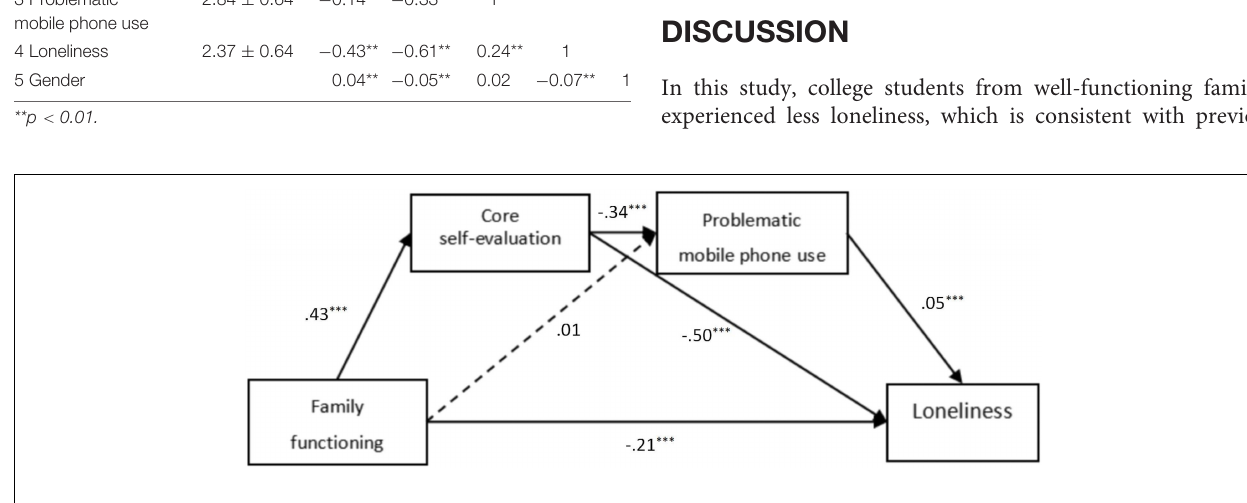
FIGURE 2 | Chain mediation model. ∗∗∗ p <